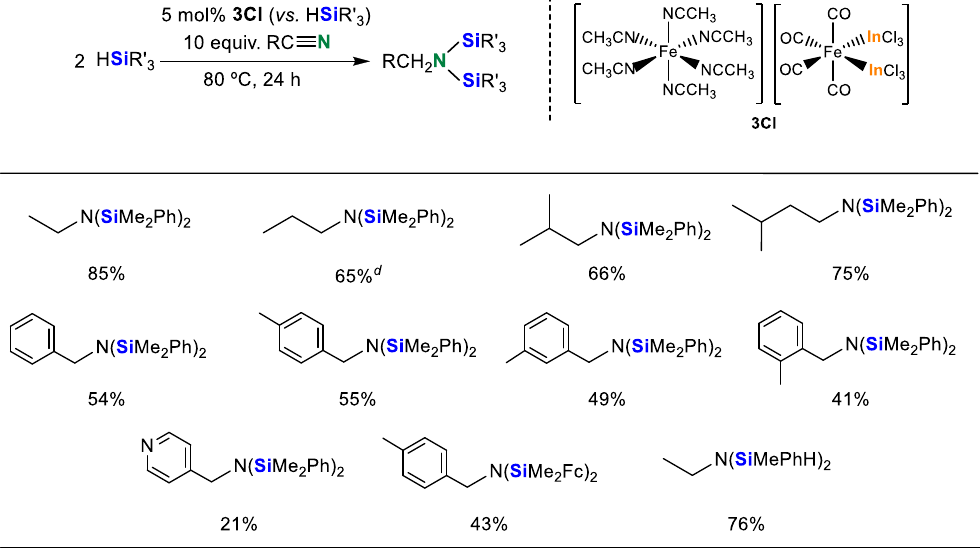
Molecules 2018 , 23 , x FOR PEER REVIEW Table 7. Double hydrosilylation of organonitriles in the presence of 3Cl a,b,c .